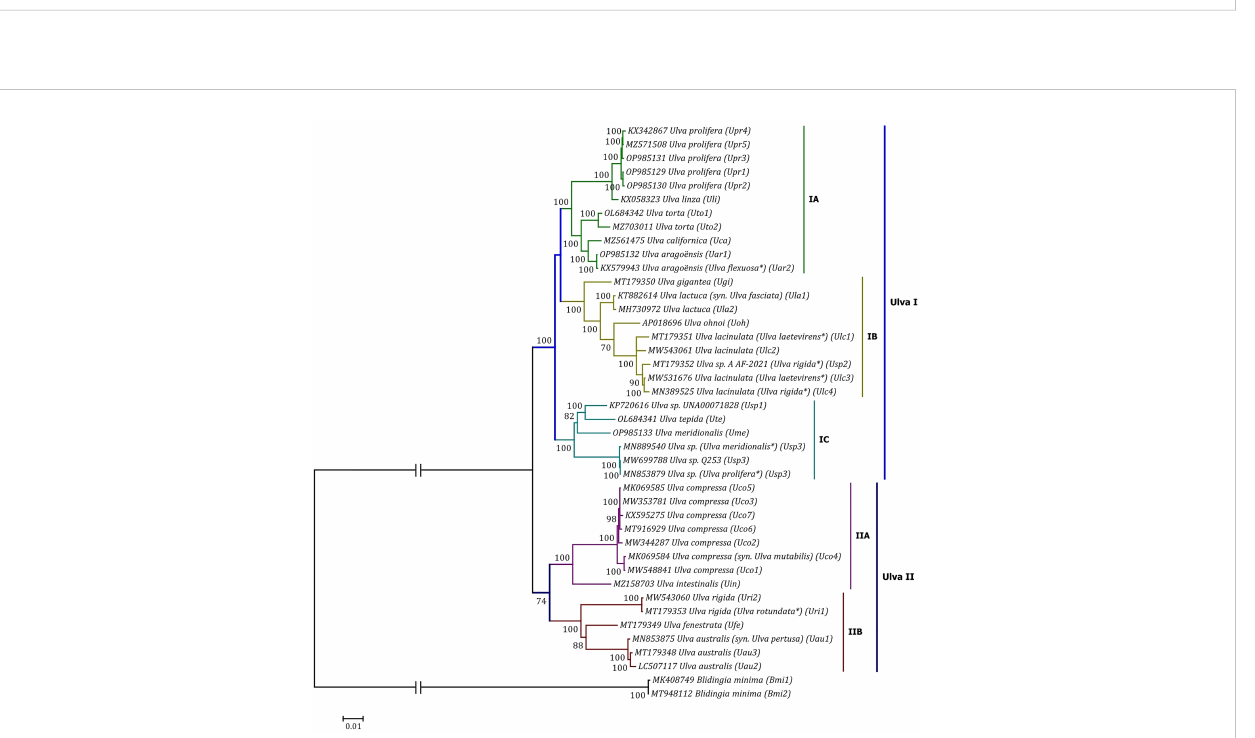
FIGURE 11 Phylogenomic tree based on Maximum Likelihood (ML) analysis of the amino acid (aa) sequences of the 71 common PCGs in the 40 Ulva plastomes. The bootstrap support values greater than 70% were displayed at branches. Branch lengths are proportional to the amount of sequence change, which are indicated by the scale bar below the trees. The tree was rooted with Blidingia minima as the outgroup. The asterisk indicates that the species name has been